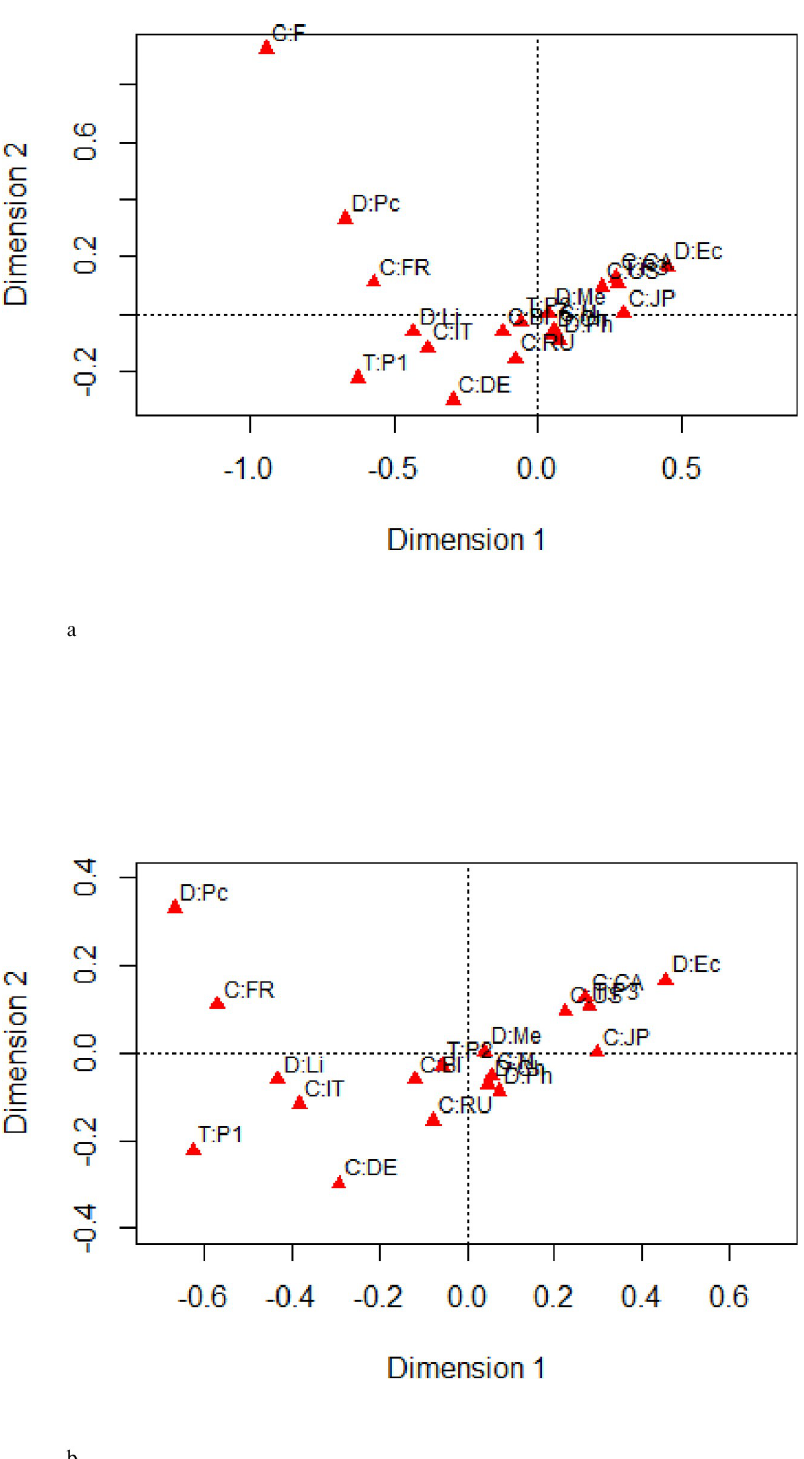
Fig 2. a. Two-dimensional correspondence plot of Table 1 from the JMCA. b. Zoomed in version of Fig 2A after removal of the highlighted point.